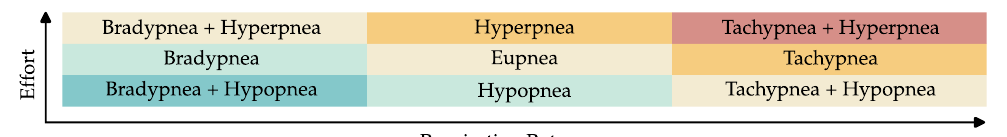
Figure 1. Qualitative respiration rate- and depth-based pattern differentiation. Hyperventilation and hypoventilation are marked by red and blue, respectively. The more saturated the color, the more pronounced the condition.